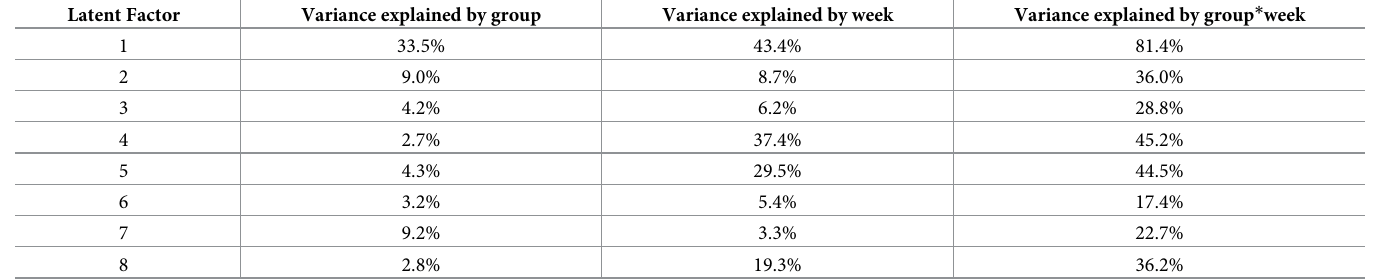
Table 2. Percentage of variance of each LF that is explained ( R 2 ) by mouse group (column 2), week (column 3), and by both mouse group and week (based on a lin- ear model comprising interaction terms, column 4). Latent Factor Variance explained by group